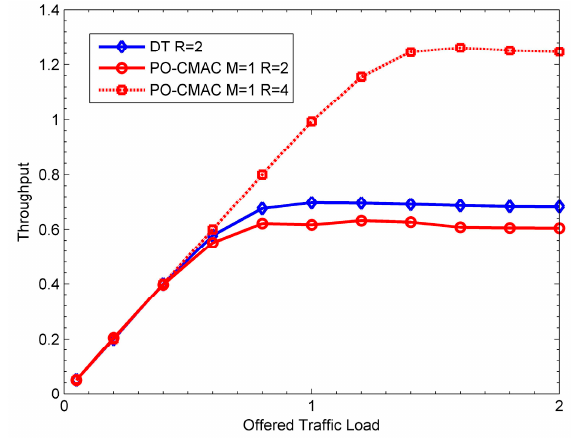
Figure 20. Throughput vs. offered traffic load.